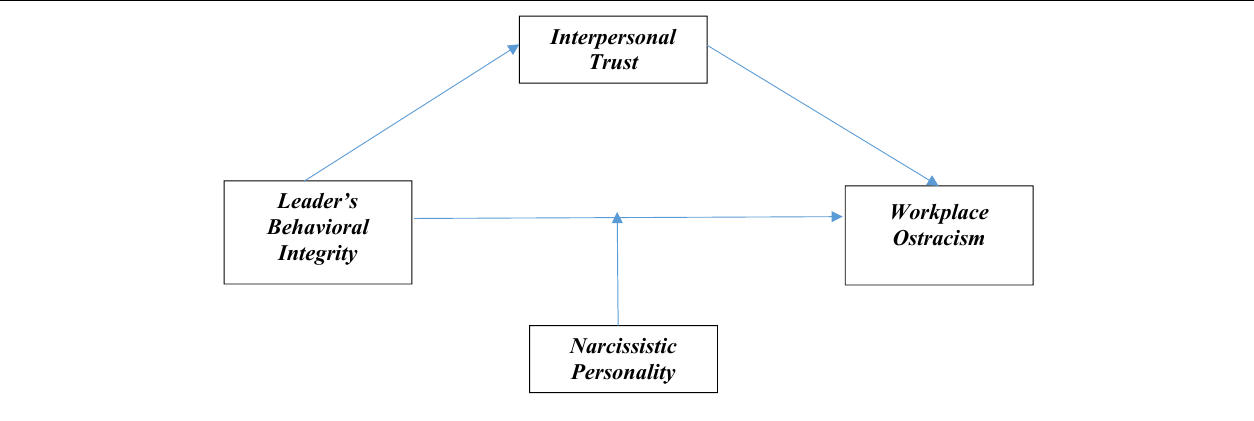
FIGURE 1 | Conceptual